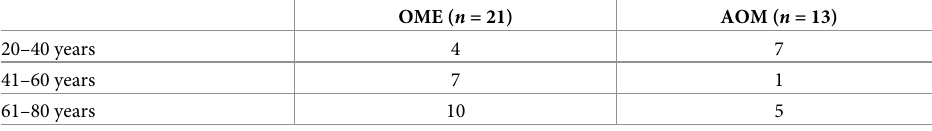
Table 1. Age distribution of OME and AOM